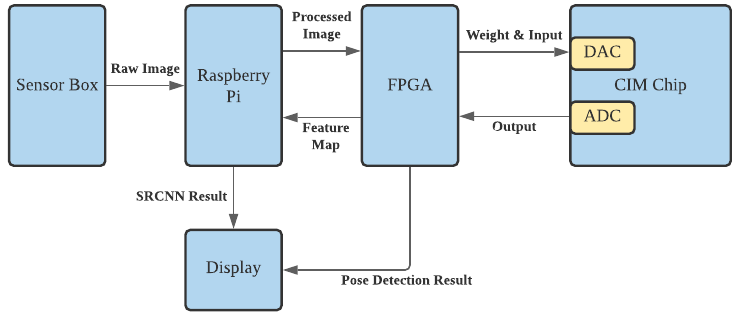
Figure 5. Overall System Architecture of CIM-Based Smart